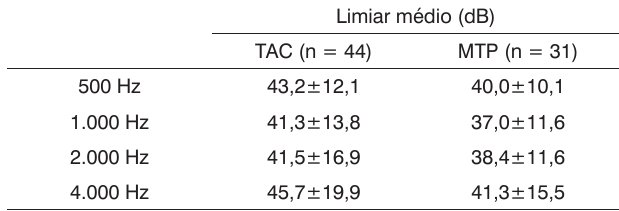
Tabela 3. Limiares audiométricos pós-operatórios médios de tons puros com o implante coclear de acordo com